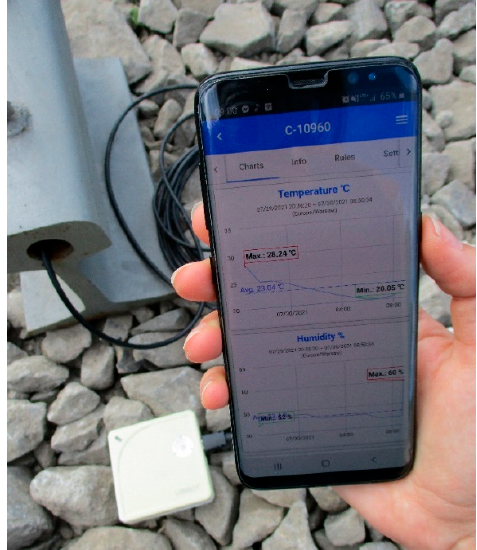
Figure 4. Management Console—UbiBot App.